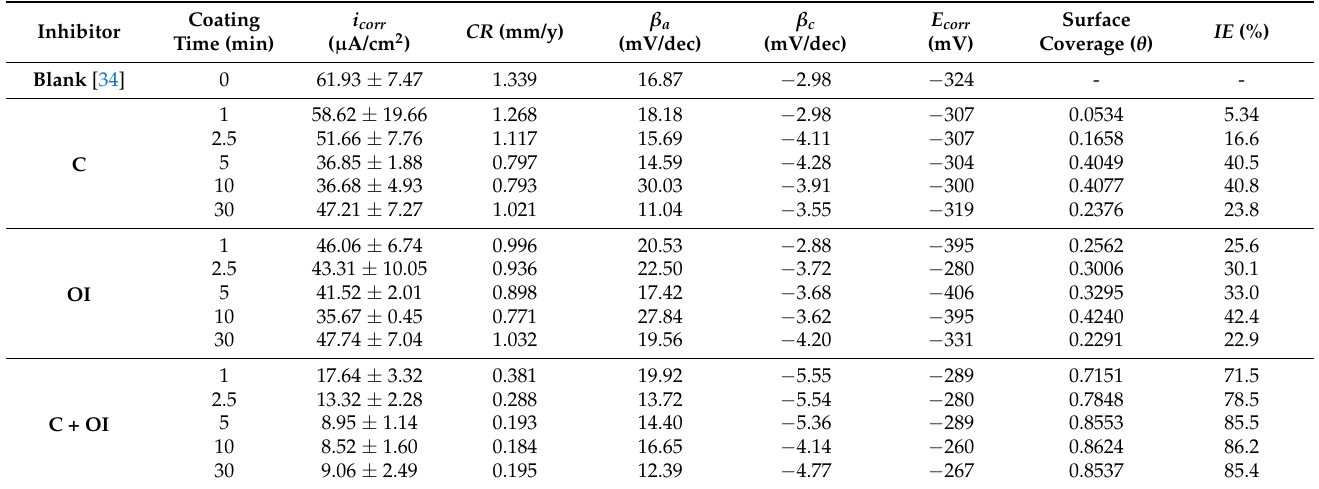
Table 5. PP results for C, OI and C + OI each 50 mmol/L at different immersion times tested in 0.1 M NaCl. CR is given in millimeter per year (mm/y) depending on current density i corr . The corrosion reduction efficiency is given as IE in